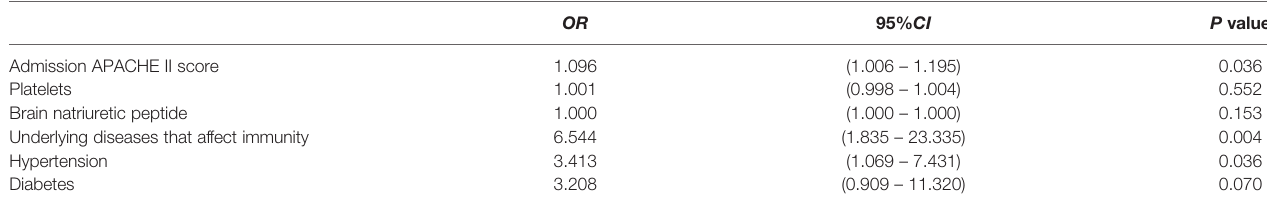
TABLE 4 | Risk factors for mNGS or culture –